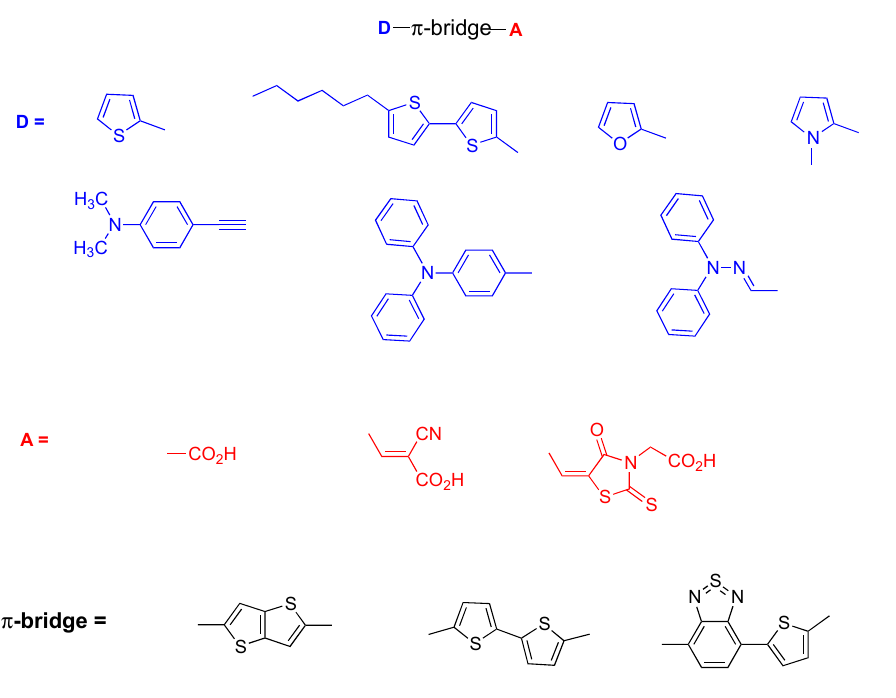
Figure 1. Push-pull heterocyclic sensitizers for DSSCs [46–50].